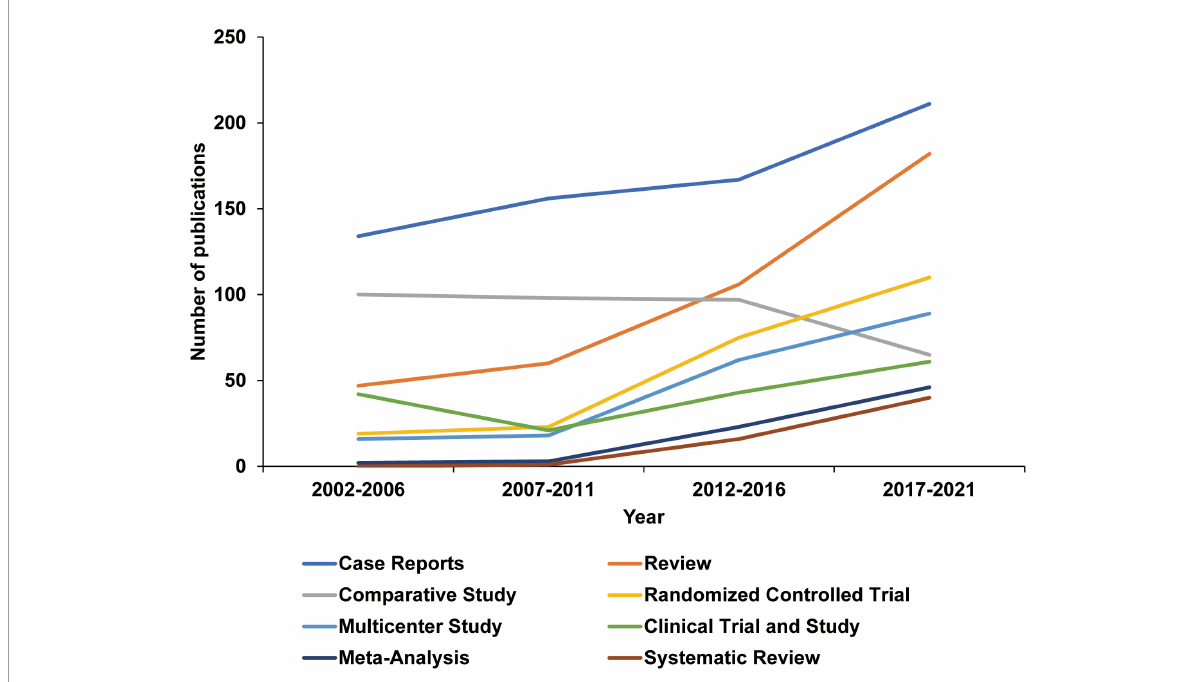
FIGURE2 Changes in depression and radiology publication types over the last 20 years. Publication types are defined by the PubMed database and extracted using Python.